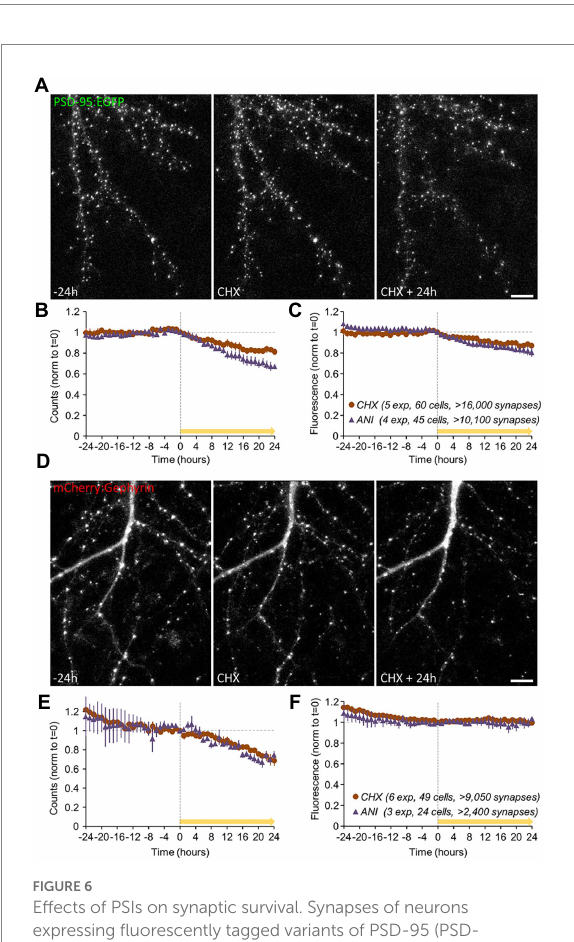
FIGURE 6 Effects of PSIs on synaptic survival. Synapses of neurons expressing fluorescently tagged variants of PSD-95 (PSD- 95:EGFP); data in (A–C) and Gephyrin (mCherry:Gephyrin); data in (D–F) were imaged at 1-hour intervals by confocal microscopy. The synapses were followed under